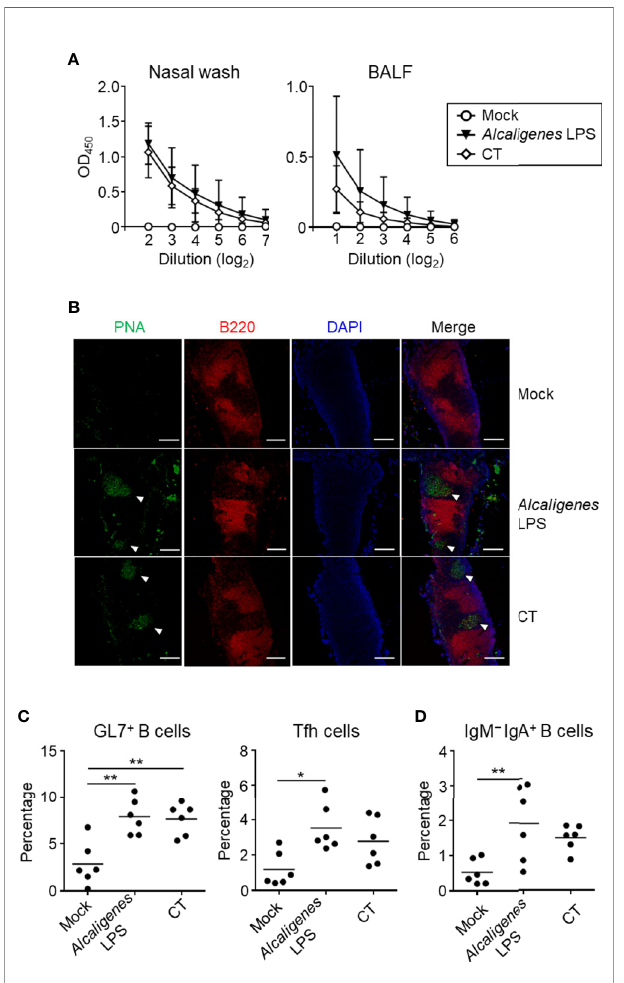
FIGURE 1 | Alcaligenes LPS promotes mucosal OVA-speci fi c IgA antibody production upon nasal immunization. Mice were nasally immunized three times with OVA alone (Mock) or with OVA plus Alcaligenes LPS or CT; one week after the fi nal immunization, (A) Nasal wash and BALF were collected to determine levels of OVA-speci fi c IgA by ELISA. (B) Formation of GC in NALT were observed by immunohistochemical analysis. PNA: GC marker; B220: B cell marker; arrow heads: GC location. Induction of GC GL7 + B cells (gated on: CD3 ϵ − B220 + GL7 + ) and Tfh cells (gated on: CD3 ϵ + CD8 a − CD4 + PD-1 + ) (C) and of IgM − IgA + B cells (gated on: CD3 ϵ − B220 + GL7 + IgM − IgA + ) (D) in NALT were analyzed by fl ow cytometry ( n = 5 or 6 per group). Data are representative of two independent experiments and statistical signi fi cance was determined by one-way ANOVA (* p < 0.05; ** p < 0.01).